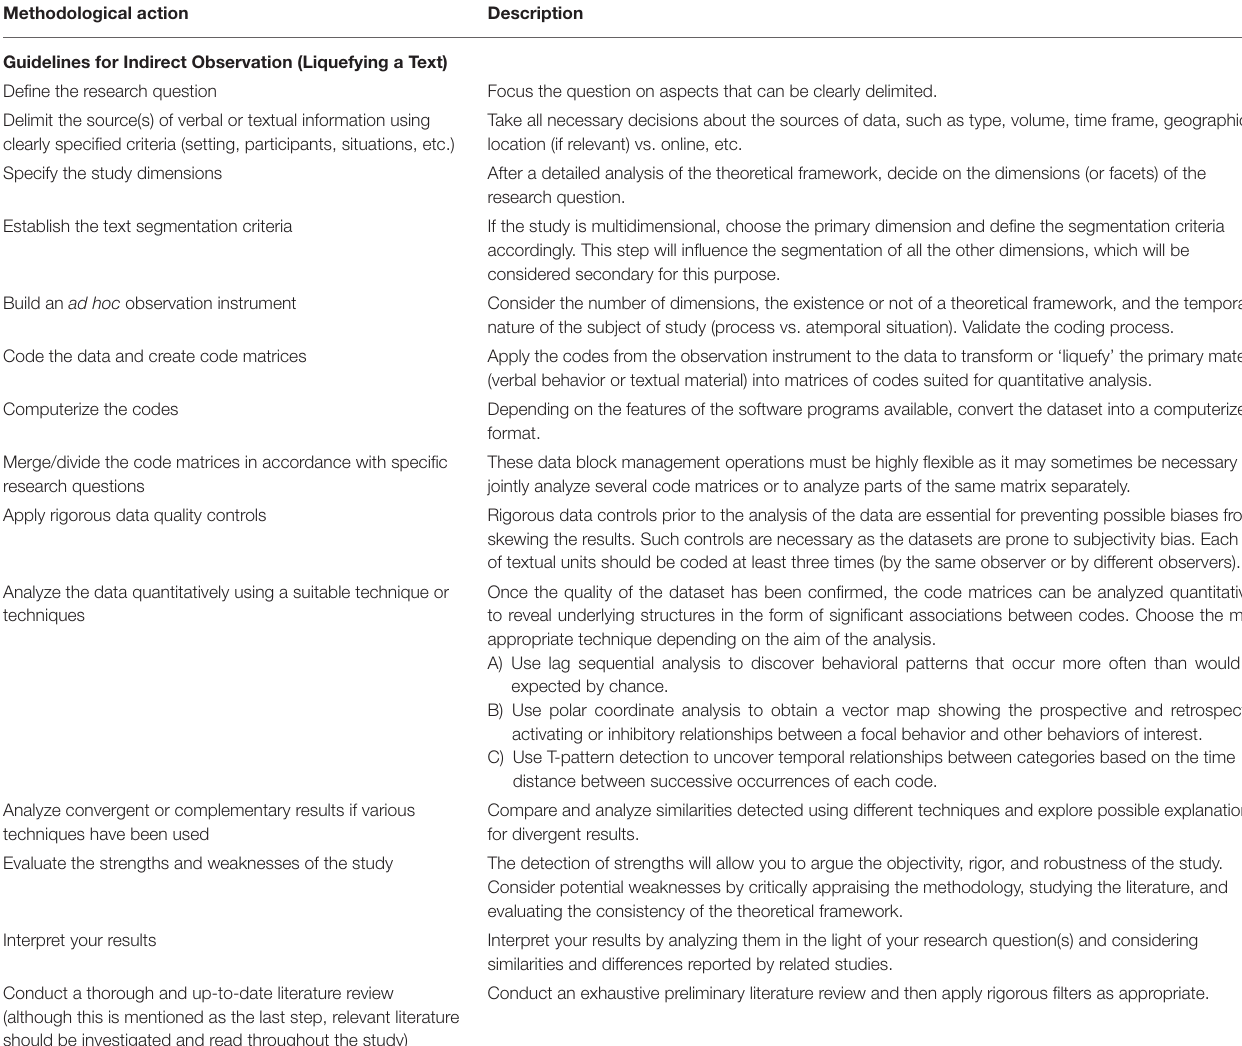
TABLE 9 | Procedure for conducting an indirect observation study based on liquefying a